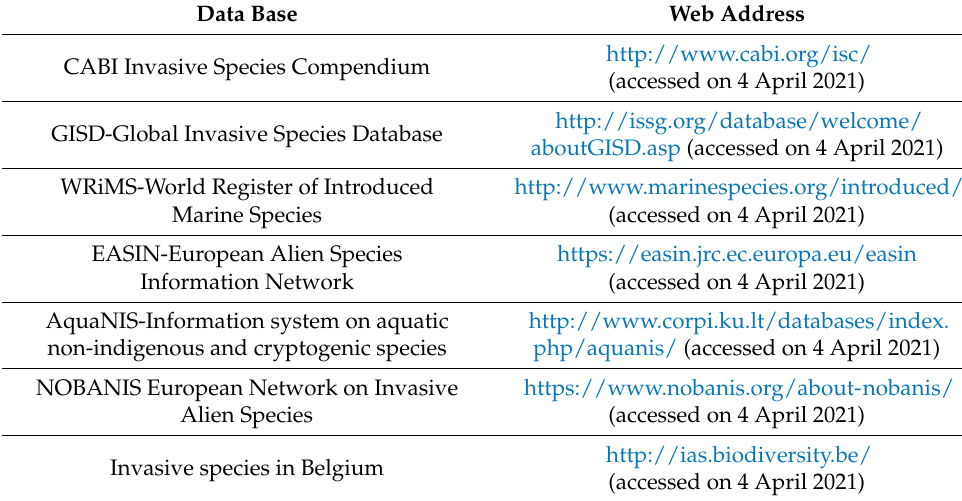
Table 1. Examples of data bases containing information on introduced species at the global and regional